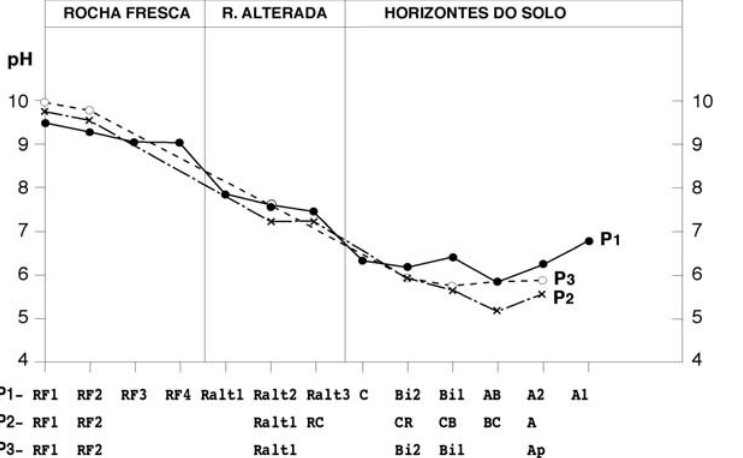
Figura 3. Evolução do pH de abrasão nos perfis de alteração